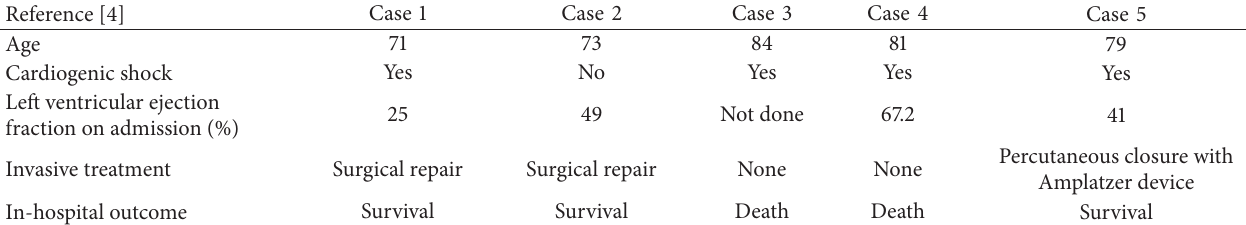
Figure 5: (a) Catheterization of the left ventricle and the ventricular septal perforation was achieved with an Amplatzer 1 guiding catheter; ((b) and (c)) guide wire deployed in pulmonary artery and the snore in the right atrium (arrow); ((d) and (e)) Amplatzer device previous implantation through the right to left ventricle; (f) Amplatzer device appropriately deployed (arrow). Table 1: Treatment and clinical outcome in patients with takotsubo cardiomyopathy complicated with ventricular septal